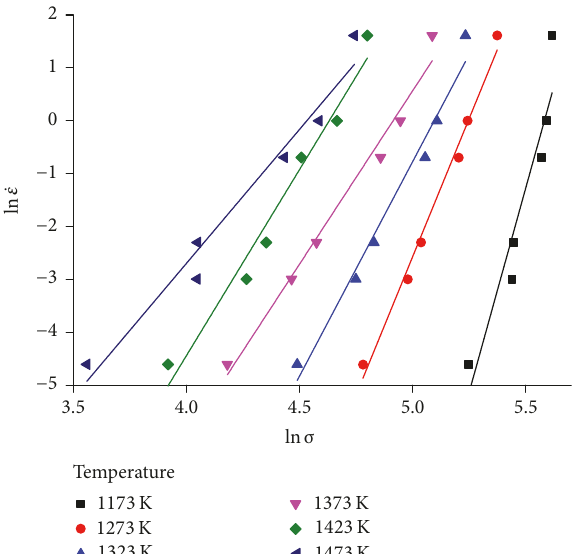
Figure 7: Relationship between ln ̇𝜀 and ln [ sinh (𝛼𝜎)] .